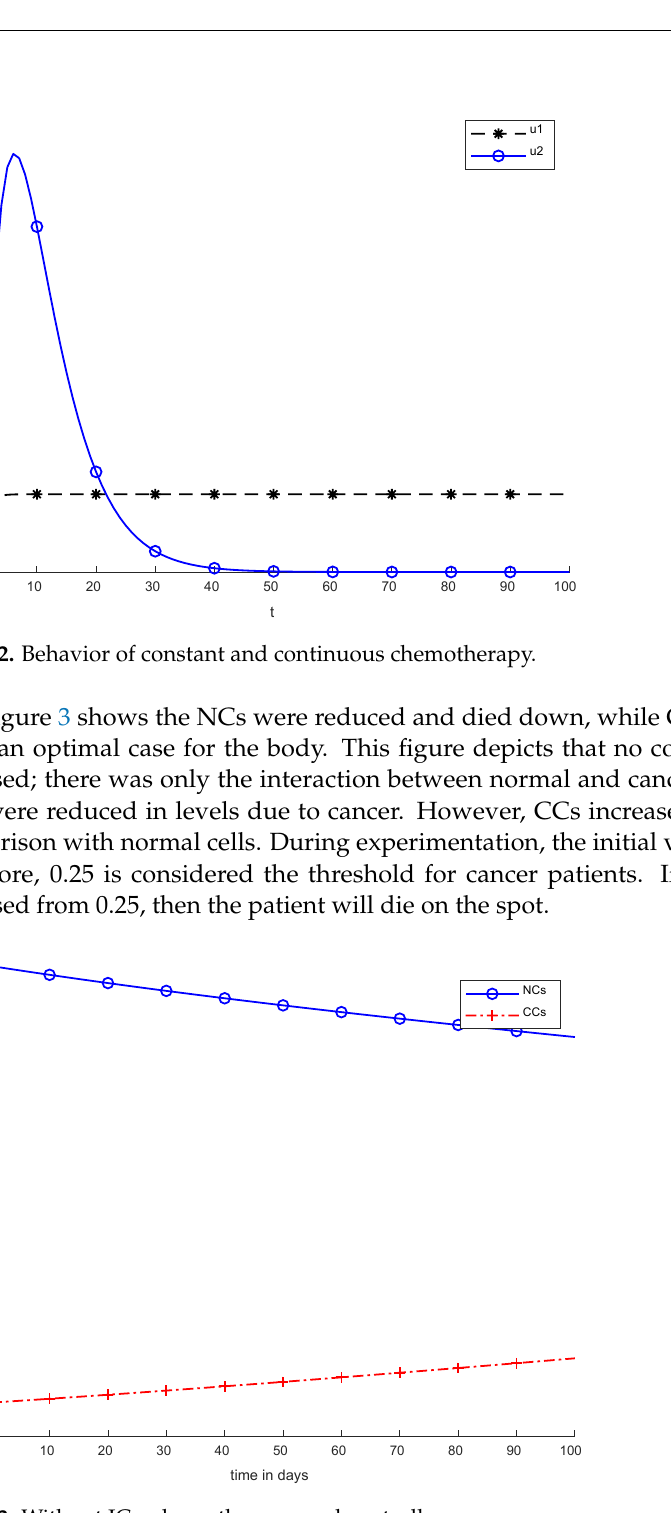
Figure 3. Without ICs, chemotherapy, and controller.